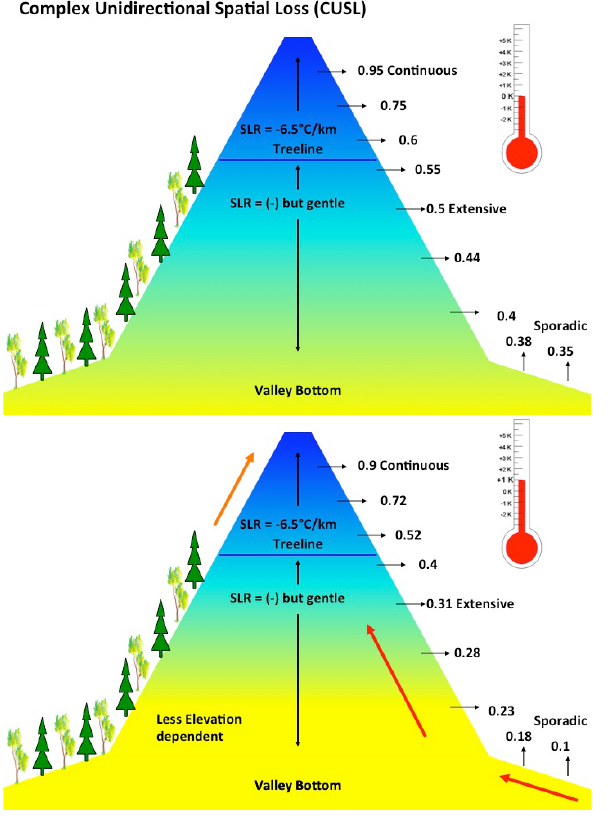
Fig. 13. (Upper) Conceptual diagram of permafrost probability vari- ation in an area susceptible to complex unidirectional spatial loss; (lower) equilibrium permafrost probabilities following a warming scenario.